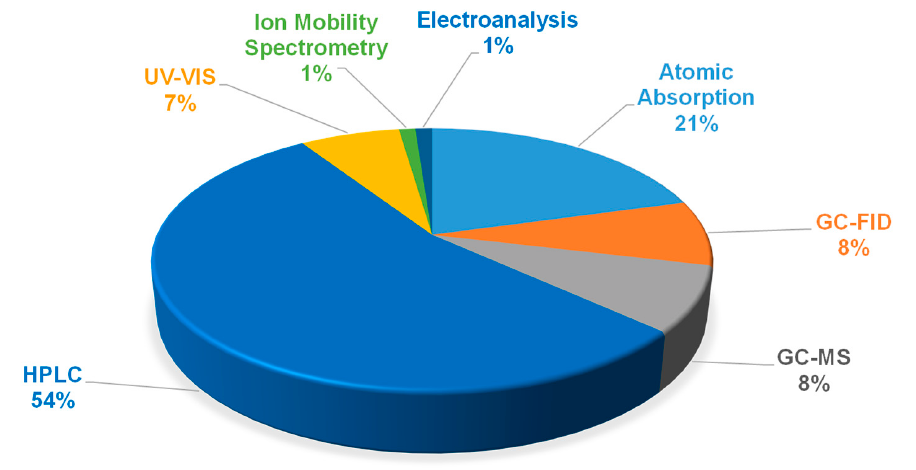
Figure 5. Percentage distribution of the published papers (2010–2020) on eutectic solvents in the development of analytical methods as function of the analytical method used after the extraction.